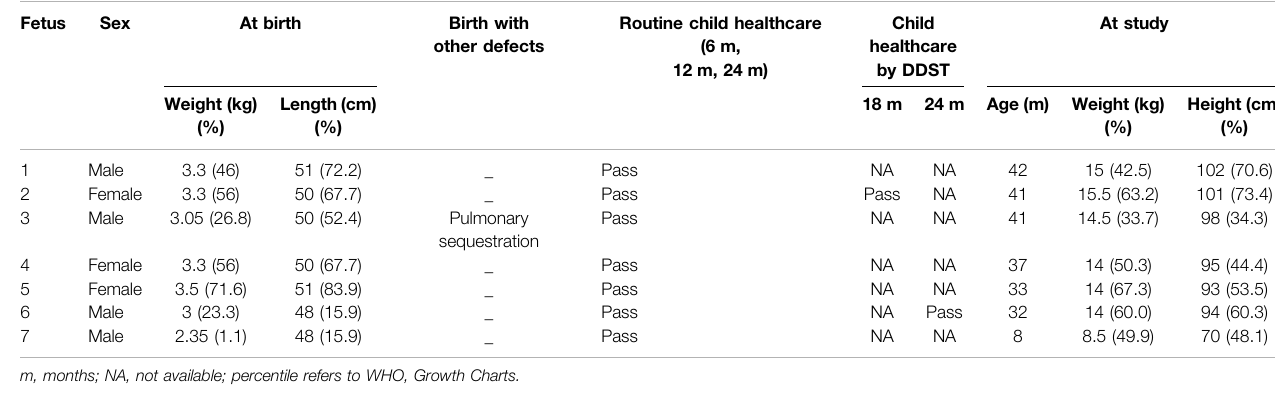
TABLE 2 | Clinical follow-up evaluation of 7